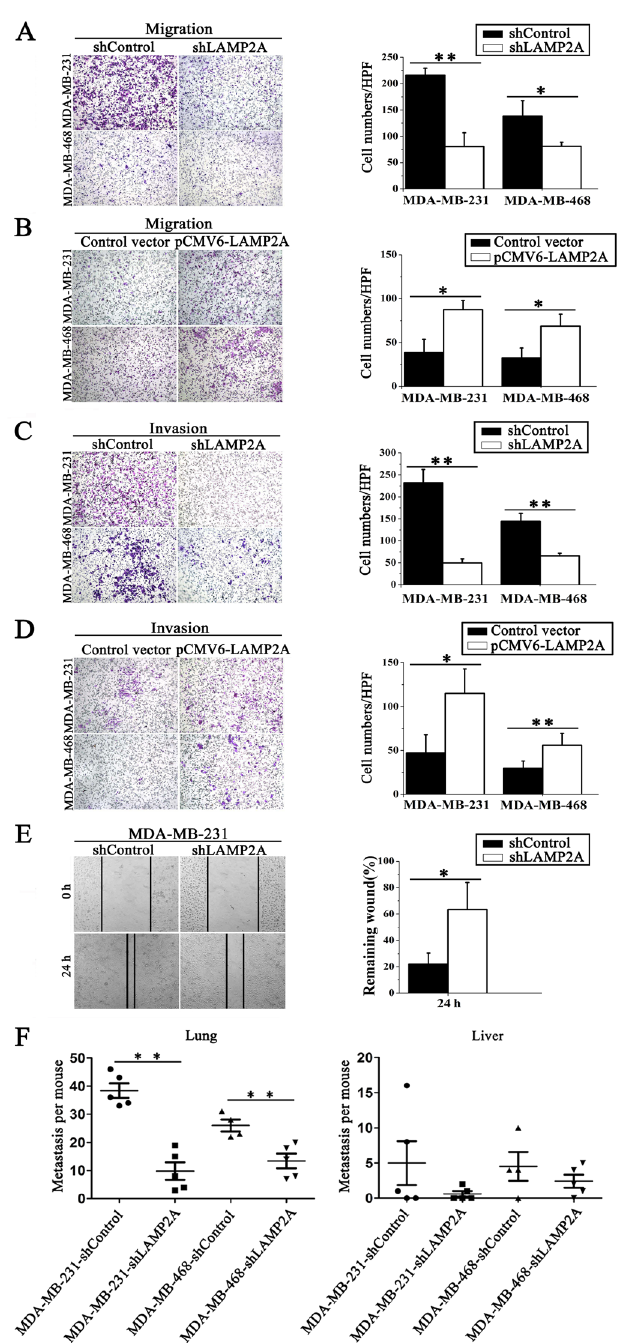
Figure 3. CMA promotes breast cancer cell migration and invasion in vitro and in vivo . ( A ) and ( B ) The migration of breast cancer cells was detected using a Transwell migration assay. shLAMP2A or shControl MDA-MB-231 and MDA-MB-468 cells ( A ) or transient LAMP2A-overexpressing or control MDA-MB-231 and MDA-MB-468 cells ( B ) were cultured for 6 h, and the cells that migrated to the lower chamber were observed by a microscope after crystal violet staining (left) and counted (right). ( C ) and ( D ) The invasion ability of the two breast cancer cell lines was detected using a Transwell Matrigel invasion assay. shLAMP2A or shControl cells ( C ) and LAMP2A- overexpressing or control cells ( D ) were cultured for 48 h, and cells that invaded into the lower chamber were observed by a microscope after crystal violet staining (left) and counted (right). ( E ) The migration of breast cancer cells was measured by a wound-healing assay. The cells were cultured for 24 h after the wound scratch, and the size of the wound at different times was observed by a microscope (left). The size of the wound was quantified (right). All values are the means ± SD of three different experiments; * P < 0.05, ** P < 0.01. ( F ) Nude mice were injected with either shLAMP2A or shControl MDA-MB-231 cells or with shLAMP2A or shControl MDA-MB-468 breast cancer cells via the tail vein. At 60 days after the tail vein injection, the numbers of tumor nodes in the lungs (left) and livers (right) were counted (n = 4 to 5, ** P < 0.01, shLAMP2A or